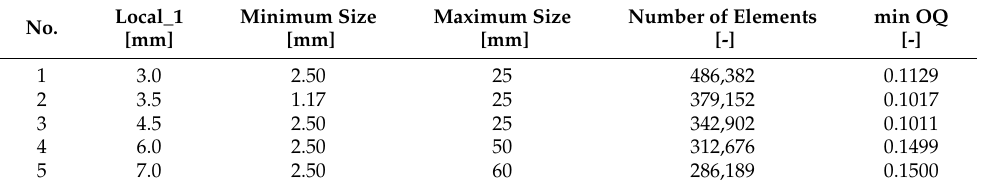
Table 3. Characteristics of numerical grids subjected to CFD analysis.